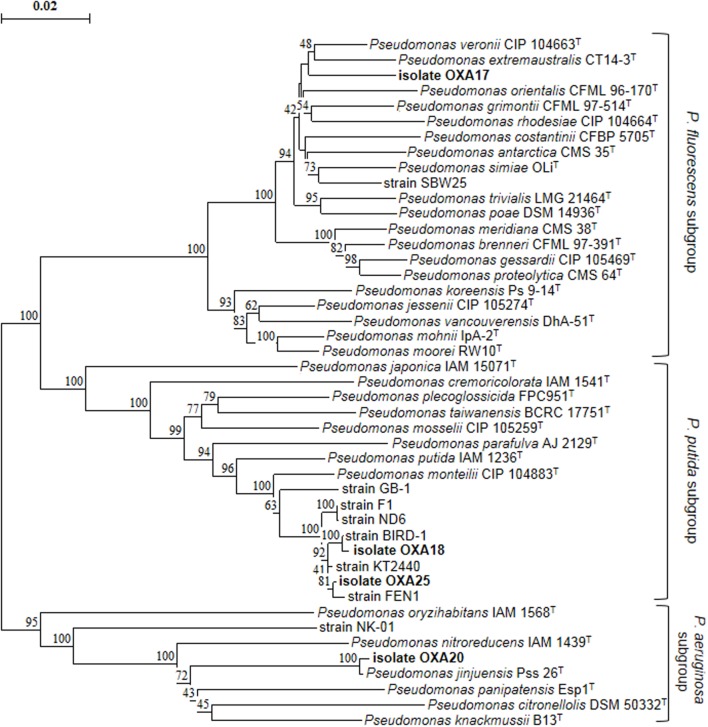
Phylogenetic position of the isolated oxamyl-degrading isolates based on concatenated MLSA of the 16S rRNA, gyrB, and rpoD gene sequences. Distance matrix was calculated by the Jukes and Cantor (1969) and the dendrogram was constructed by the neighbor-joining method (Saitou and Nei, 1987). Numbers on the nodes denote % bootstrap values based on 1,000 replicates. Scale bar represents 0.02 substitutions per site. Pseudomonas genus sub-groups were as defined by Mulet et al. (2010).